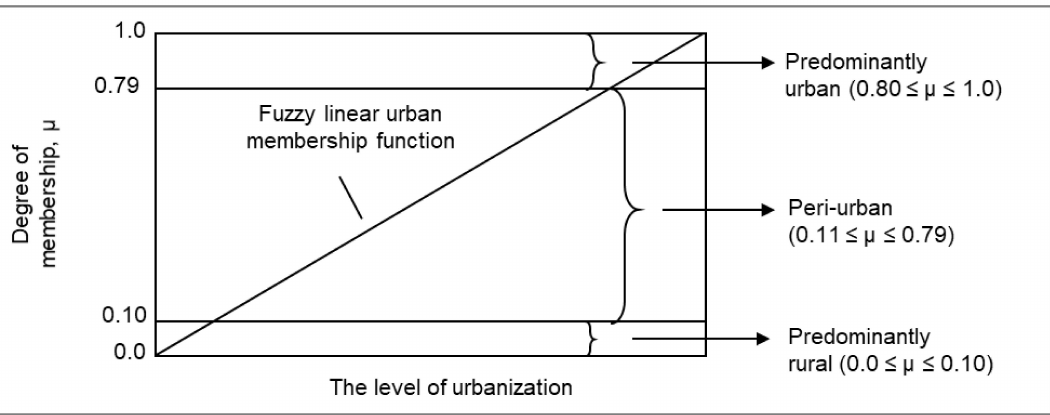
Figure 5. The level of urbanization under the microscope of fuzzy linear urban membership function